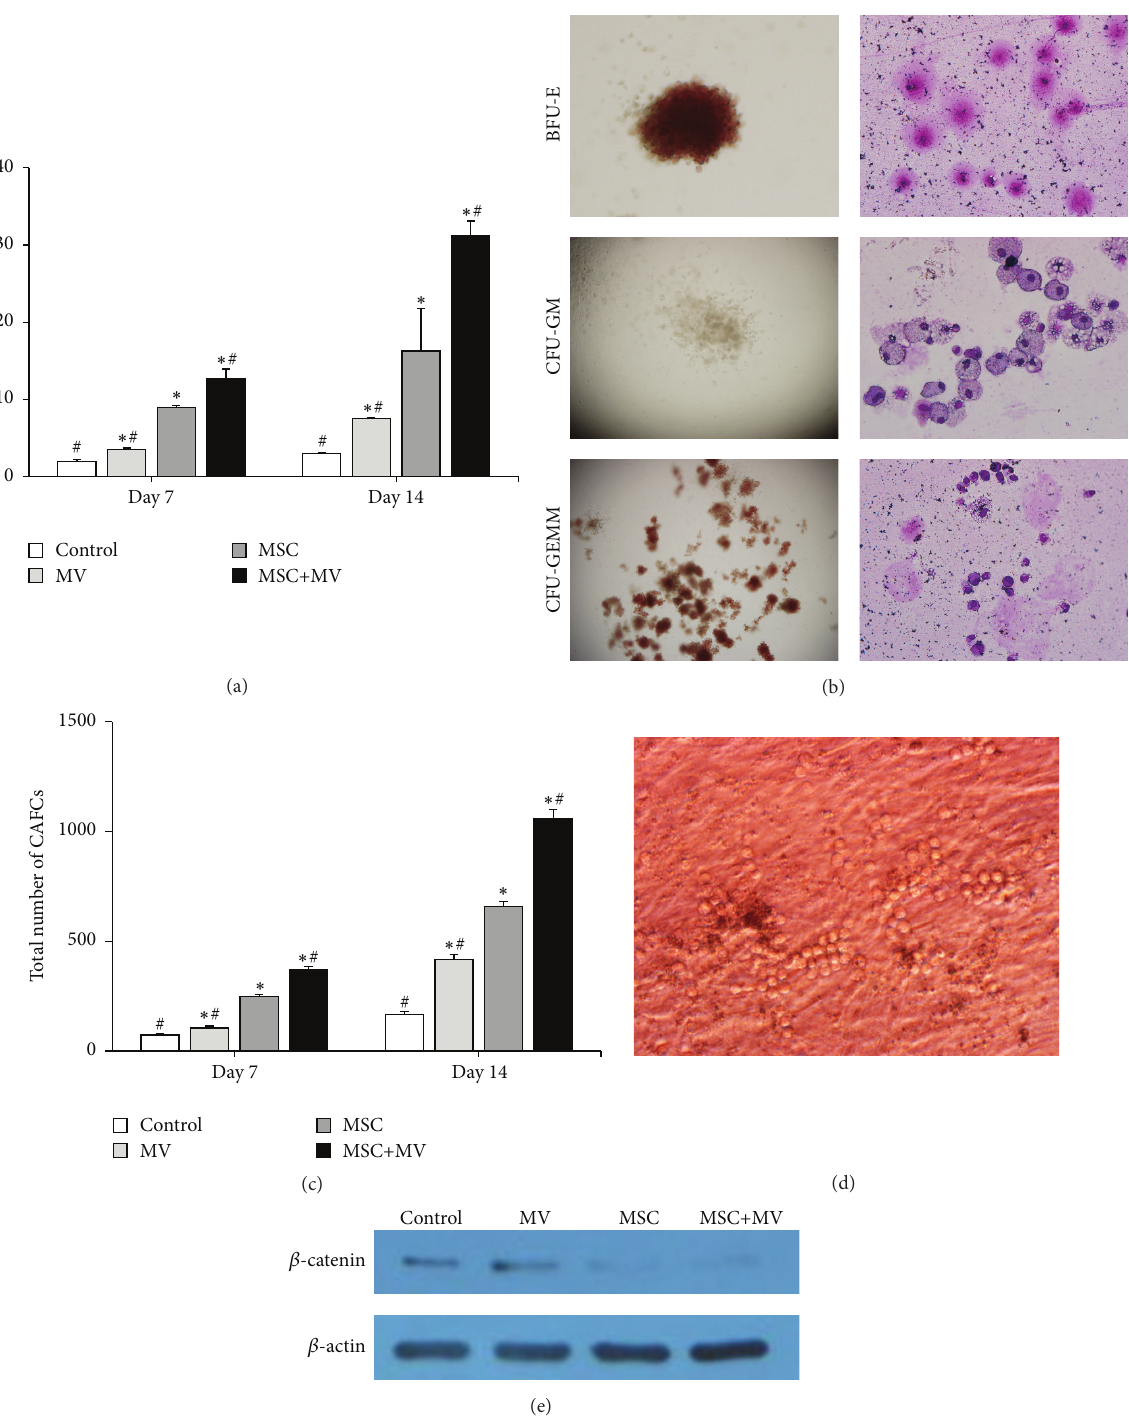
Figure 5: The effects of MSC-MVs on the generation of CFCs and CAFCs and the expression of 𝛽 -catenin in the expanded CD34 + cells. (a) Total number of CFCs generated in the four groups after 7 and 14 days of expansion ( 𝑛 = 3 ), ∗ 𝑃 < 0.05 compared with the control group, # 𝑃 < 0.05 compared with the MSC group. (b) Typical morphology of BFU-E, CFU-GM, and CFU-GEMM, observed using an inverted microscope and after Wright-Giemsa staining. (c) Total number of CAFCs generated in the four groups after 7 and 14 days of expansion ( 𝑛 = 3 ), ∗ 𝑃 < 0.05 compared with the control group, # 𝑃 < 0.05 compared with the MSC group. (d) Representative images of CAFCs. (e) Representative gel photograph of 𝛽 -catenin protein